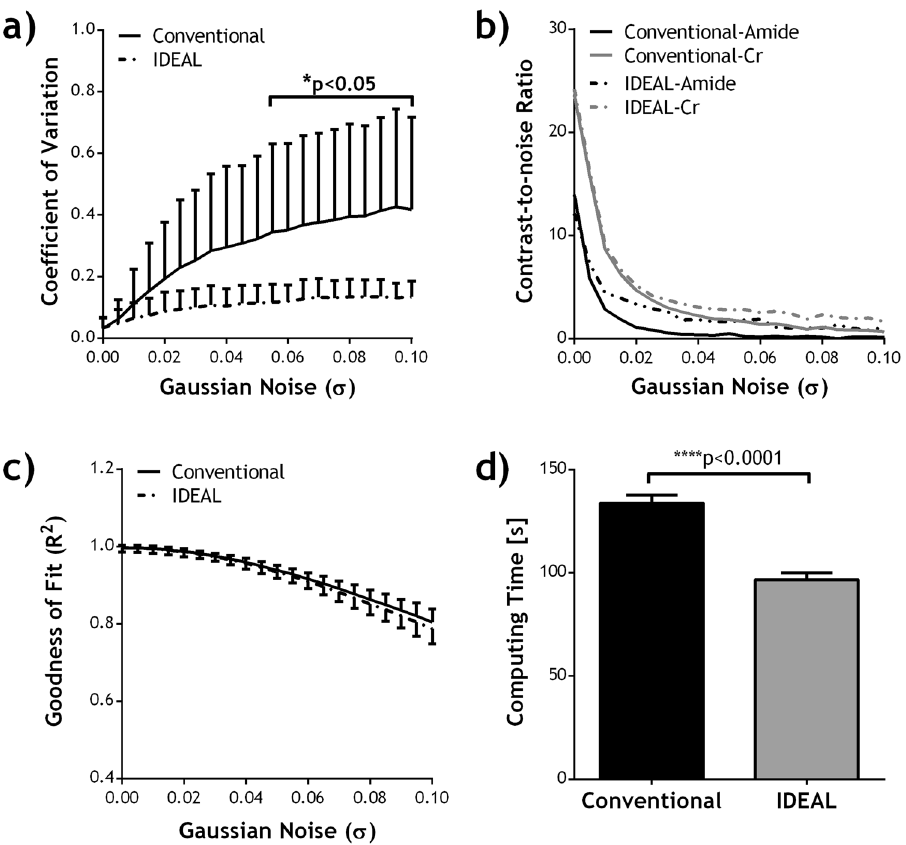
Figure 4. Comparison of fitting quality of conventional fitting and IDEAL fitting in the phantom, in terms of ( a ) coefficient of variation (COV, i.e., S.D./mean) in the fitted amplitude maps, ( b ) contrast-to-noise ratio (CNR) between the two compartments in the fitted amide and Cr amplitude maps, ( c ) R 2 as a function of noise level ( σ ), and ( d ) computing time. Paired Student's t-test was performed between the two